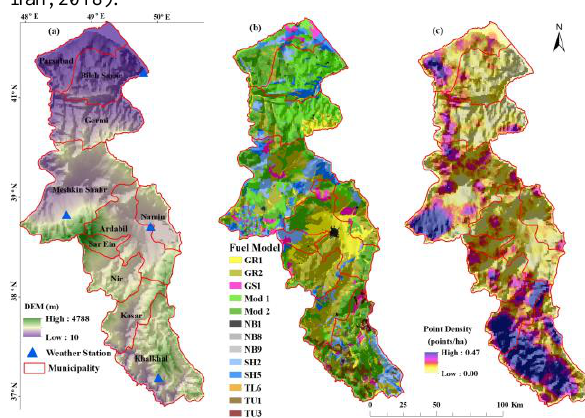
Figure 1. The spatial extent of the study area, showing the province boundaries, weather stations, and elevation (a), Fuel models (Anderson, 1982; Scott and Burgan, 2005) (b), and Ignition probability grid (IP), generated from the historical fires for the period 2005–2018. all fire ignition coordinates for the study period (Fig. 1c). north, and south of Ardabil (Figure 1a).